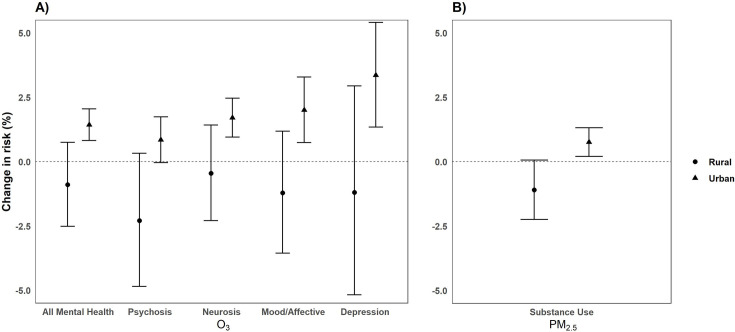
Percentage change (95% CI) in the risk of ED visits for O3 (per 10 ppb increase) (A) and PM2.5 (per 10μg/m3 increase) (B) by urbanicity from 2005–2013 in California.1 Bars: 95% Confidence Interval; CI: Confidence Interval; ED: Emergency Department; ppb: parts per billion. 1Only significant outcomes shown.